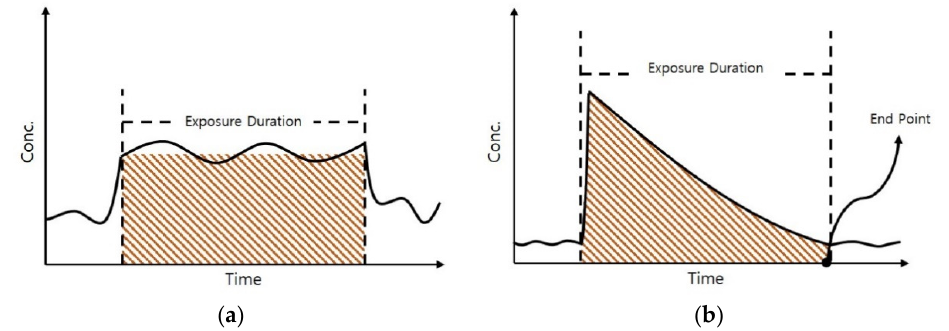
Figure 2. Exposure assessment method: ( a ) cumulative concentration, and ( b ) cumulative concentration from chemical accidents.